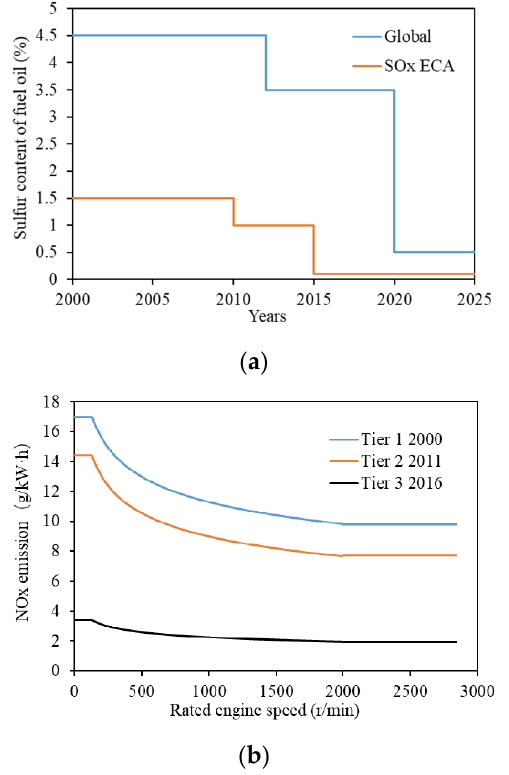
Figure 1. IMO emission regulation limits: ( a ) SO x emission limits; ( b ) NO x emission limits.